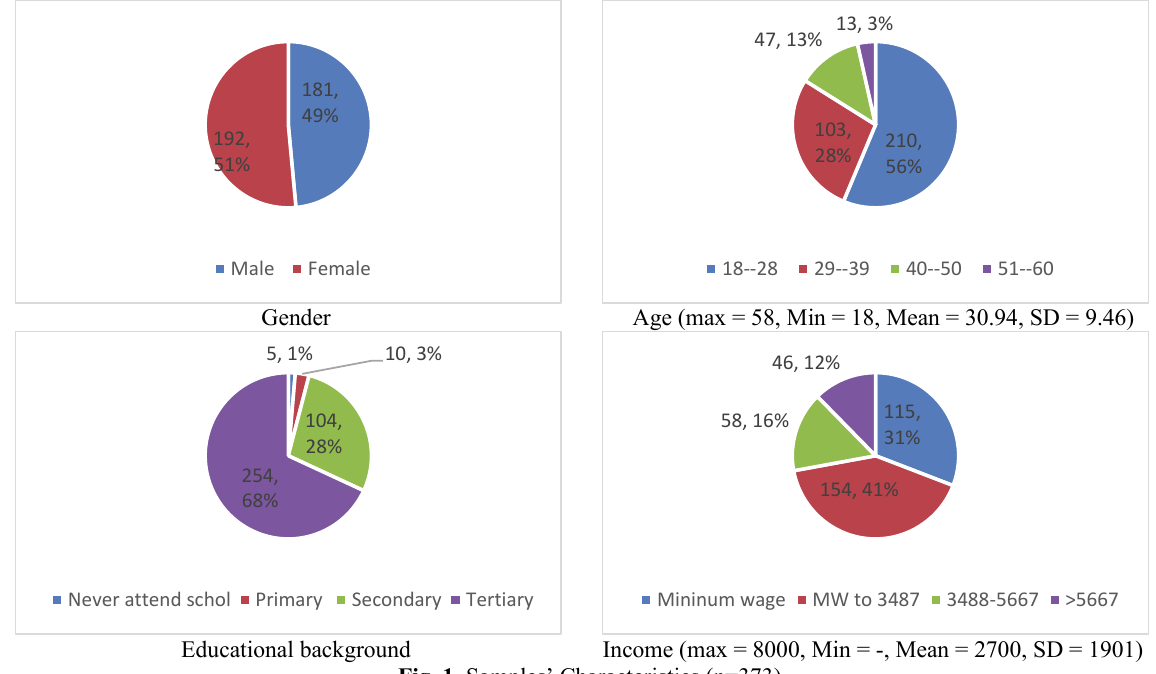
Fig. 1. Samples’ Characteristics (n=373) Note: Freq.= Frequency; %= Percentage; SD= Standard deviation; RM= Ringgit Malaysia, Malaysia’s local currency; Atten. = attended; Sch.= School; Inst.= Institution; MW= Minimum wage.